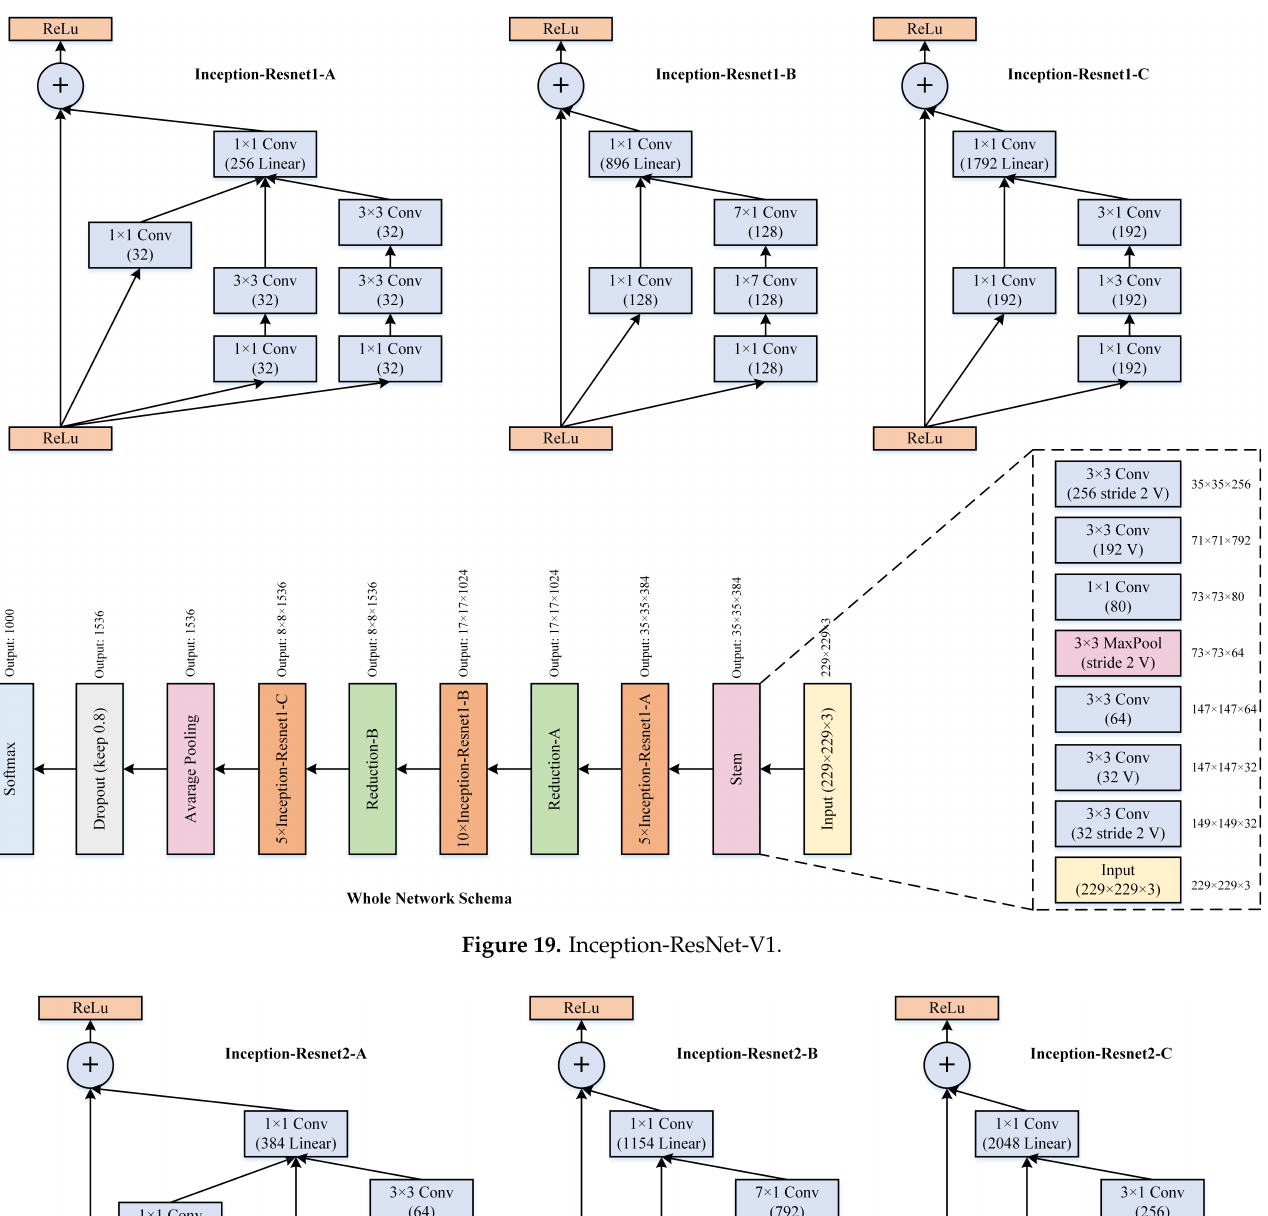
Figure 20. Inception-ResNet-V2. The number of parameters increase in some layers in comparison to